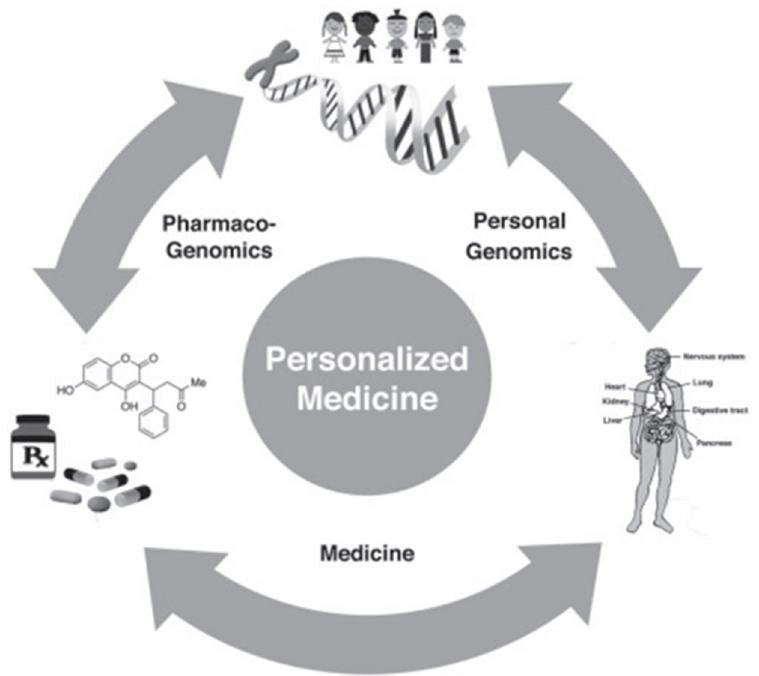
Figure 3. The cycle of translational genomics medicine indicating applications of personalized medicine for patient and population-based genomic studies, especially in pharmacogenomics.